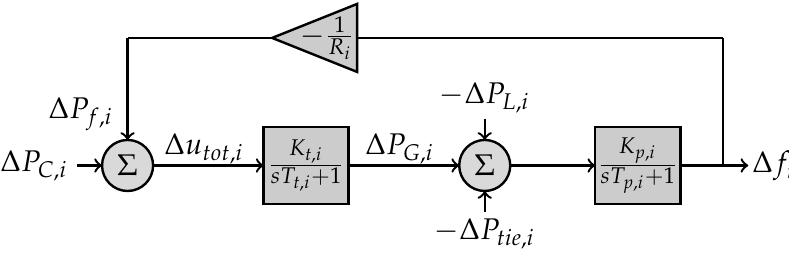
Figure 3. Single block representation of the i -th interconnected